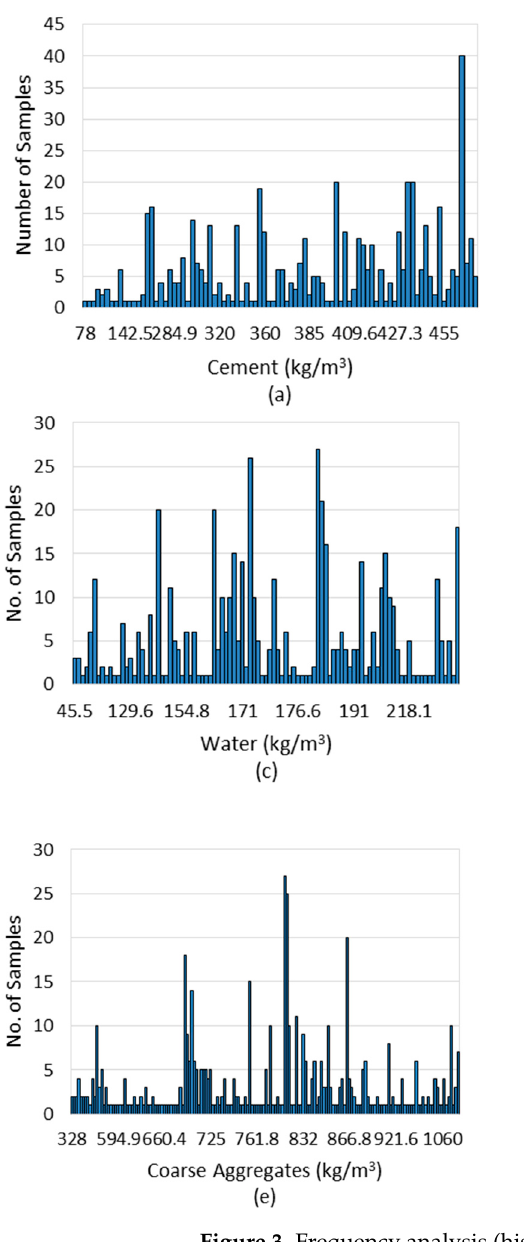
Figure 2. Minimum, mean and maximum values of output variables.